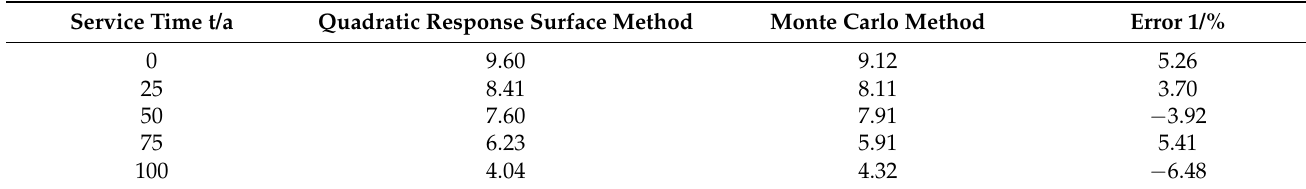
Table 2. Calculation results for the reliability index of the pile.